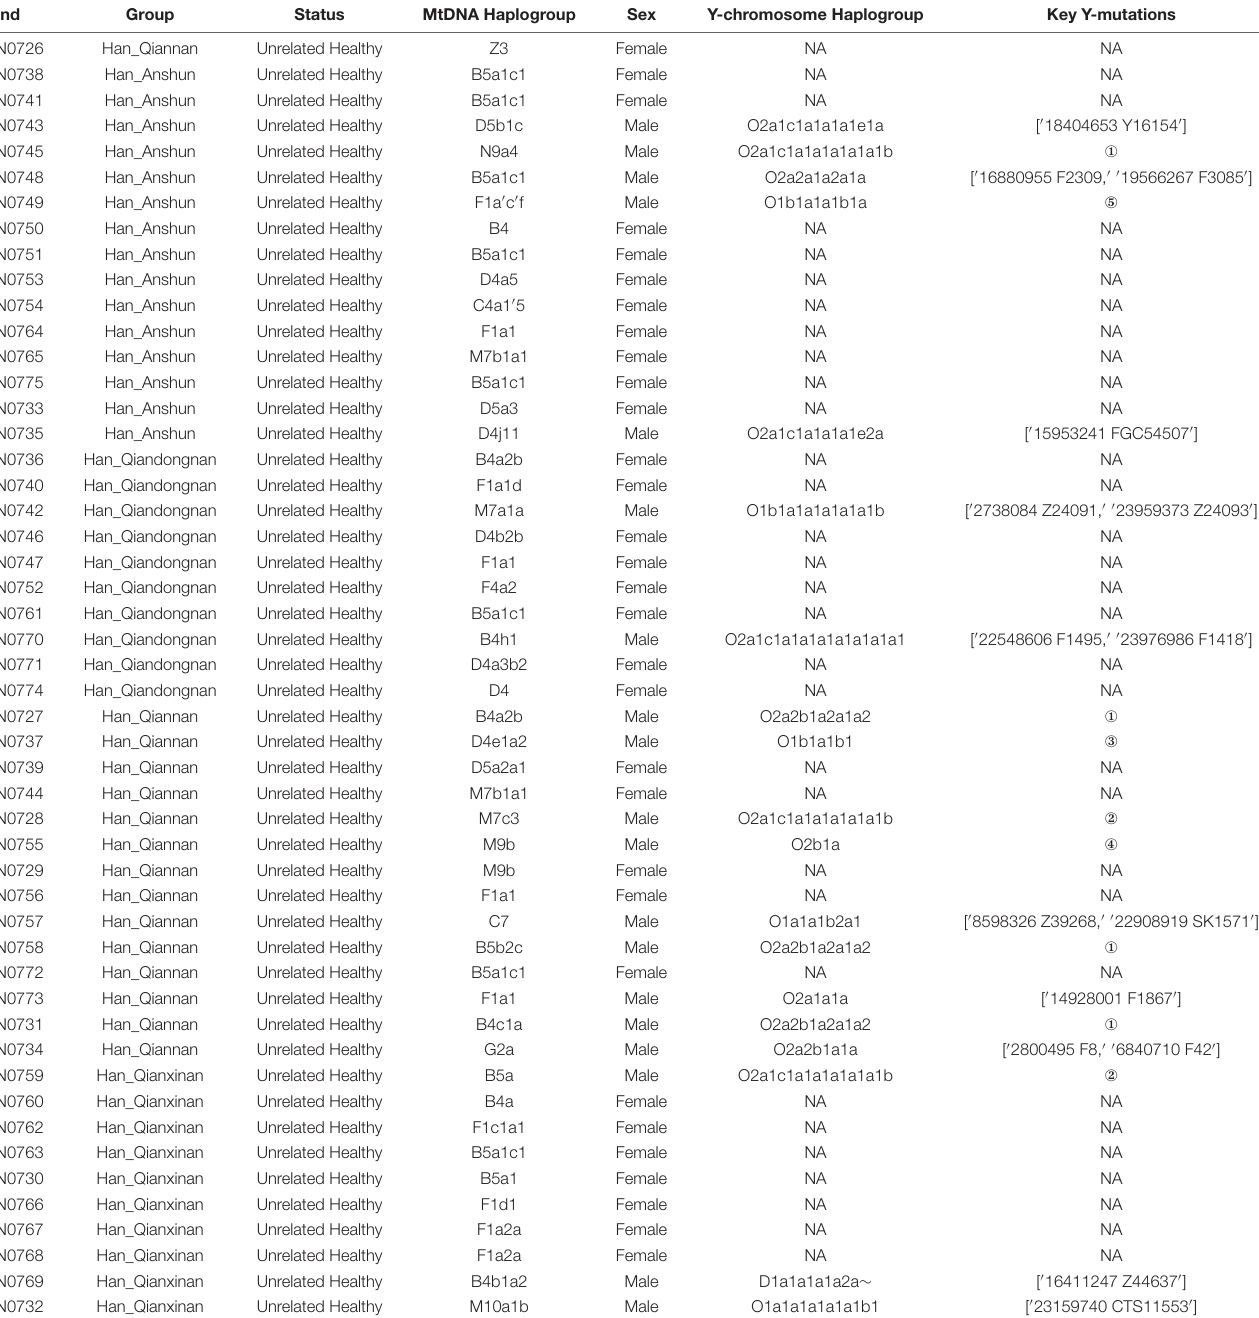
TABLE 1 | The demographical information and paternal and maternal haplogroups of our included 50 Han Chinese individuals. Ind Group Status MtDNA Haplogroup Sex Y-chromosome Haplogroup Key